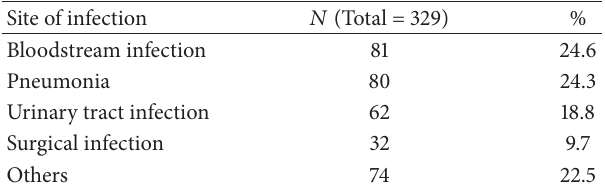
Table 2: Distribution of hospital-acquired multidrug resistant organisms by site of infection at tertiary care centre in Oman,